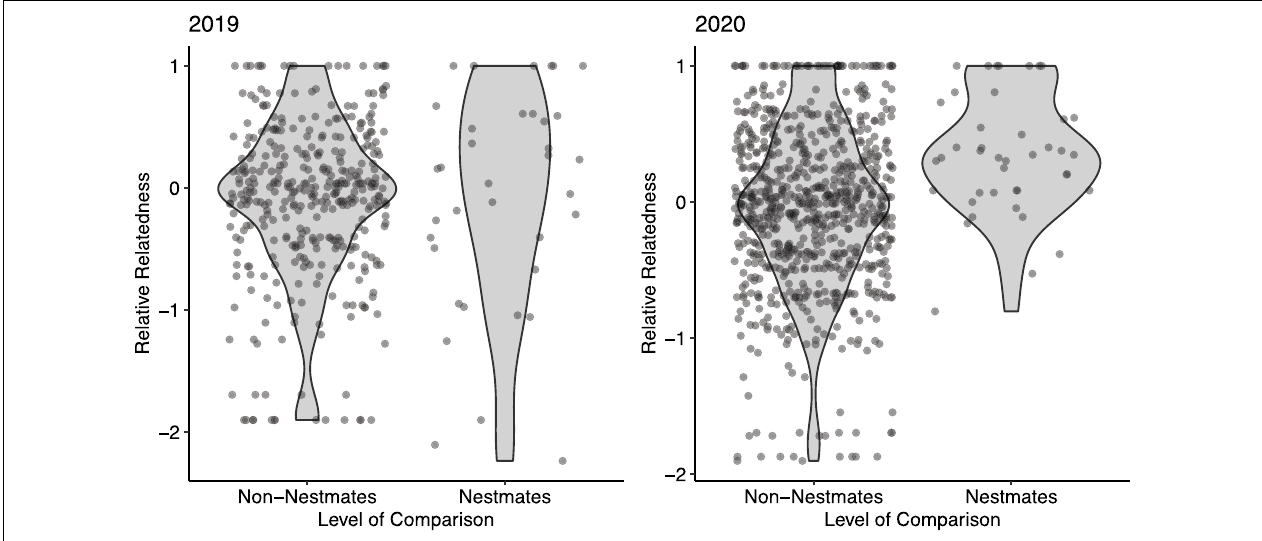
FIGURE 2 | Estimated relative relatedness ( r ) of nestmate vs. non-nestmate females in a single nesting aggregation. Each point represents a single pairwise comparison between two unique individuals in the sample. In 2019 (left), nestmates were no more related than non-nestmates (Wilcoxon test: P = 0.500). In 2020, nestmates were significantly more related than non-nestmates (Wilcoxon test: P < 0.001). Shaded areas indicate probability